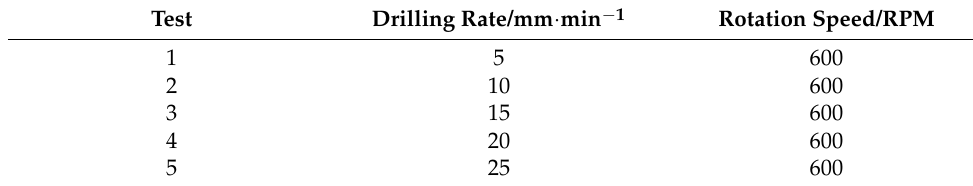
Figure 5. The phenomenon of granite core discing. Table 2. Core drilling parameters of rock.